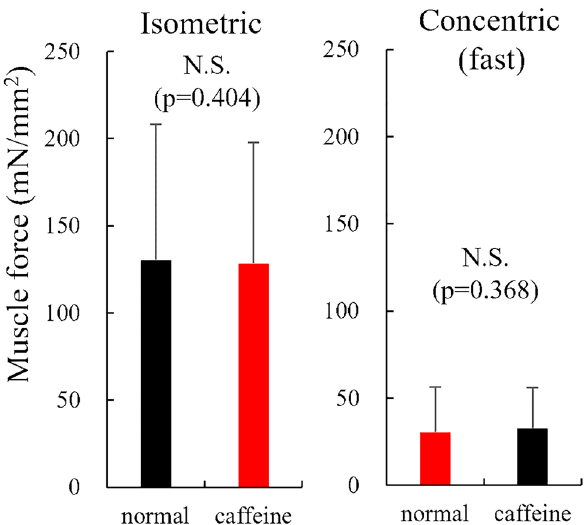
Figure 5. Muscle force obtained during the isometric and concentric phases in the fast shortening trials between normal and caffeine conditions (N = 10) (values are means ± SD).